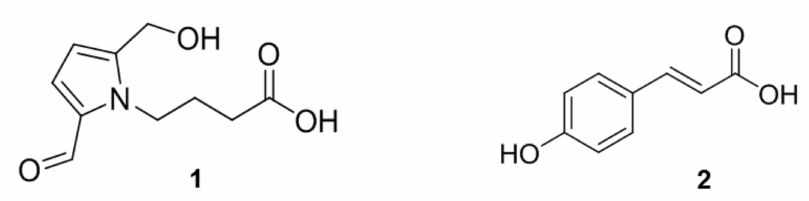
Figure 5. Chemical structures of 4-(2-formyl-5-(hydroxymethyl)-1 H -pyrrol-1-yl)butanoic acid ( 1 ) and p -coumaric acid ( 2